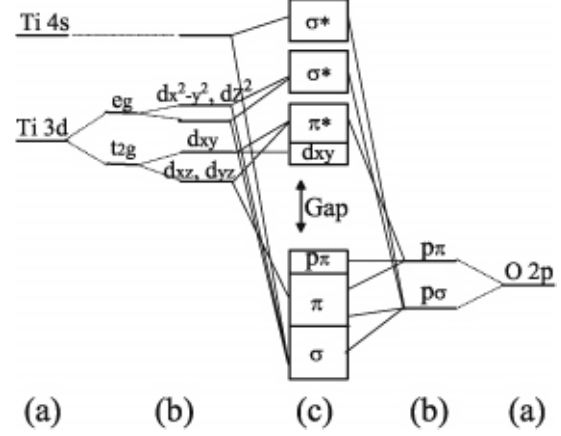
Figure 1. Electronic band structures of rutile and anatase. (a) Atomic levels; (b) crystal-filed split levels; and (c) final interactions states. The thin solid and dashed lines represent large and small contributions, respectively. (Reprint with permission from American Physical Society: Asahi R.; Taga Y.; Mannstadt W.; Freeman A. Electronic and Optical Properties of Anatase TiO 2 . J Phys Review B 2000, 61, 7459, [28]).